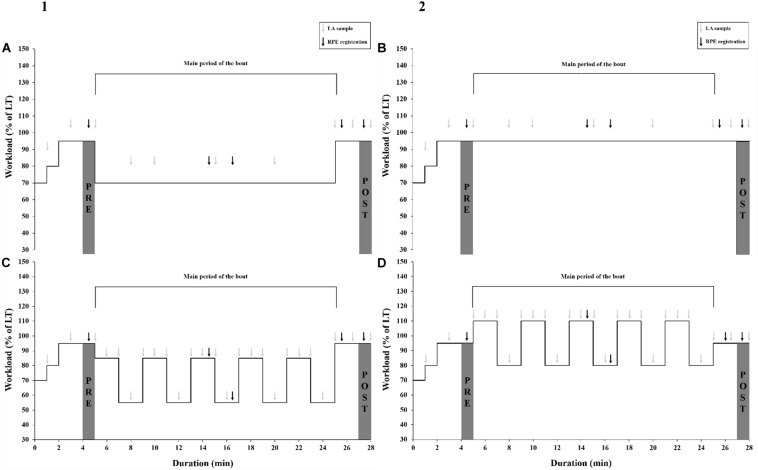
The protocol and design of the four bouts in the present study, (A) low constant (LC), (B) low variable (LV), (C) high constant (HC), (D) high variable (HV), with the incremental ramp of 5 min, the main period of the bout with work-matched VP or CP, and the final 3 min of constant power. Oxygen consumption, respiratory exchange ratio, heart rate, power output and cadence were continuously measured throughout the bout. Gray arrows indicate the time points that LA concentration was measured at. Black arrows indicate the time points that rating of perceived exertion was registered at. The gray bars visualize the time periods used for the PRE (mean during the 5th min for oxygen consumption and heart rate, lactate at the end of the 5th min and rating of perceived exertion registered after 4.5 min) and POST (mean during the 28th min for oxygen consumption and heart rate, lactate at the end of the 28th min and rating of perceived exertion registered after 27.5 min) comparison.